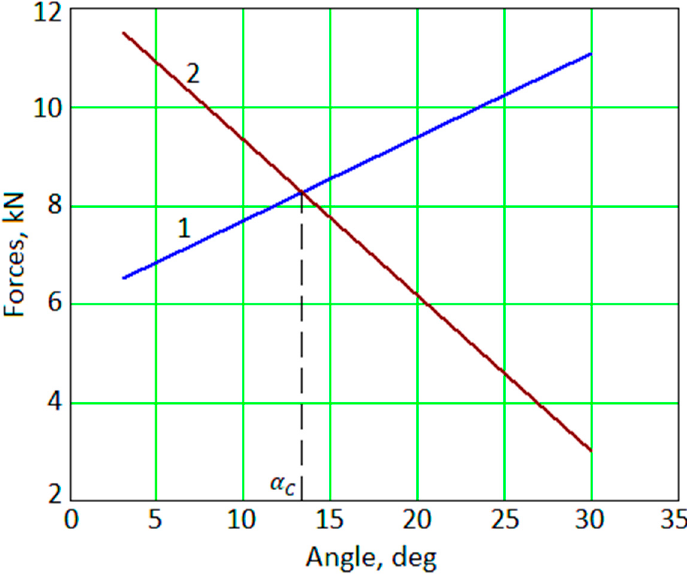
Figure 8. Dependencies of forces Q k [kN] on the lever rotation angle α k [deg]: 1— Q 1 ; 2— Q 2 .